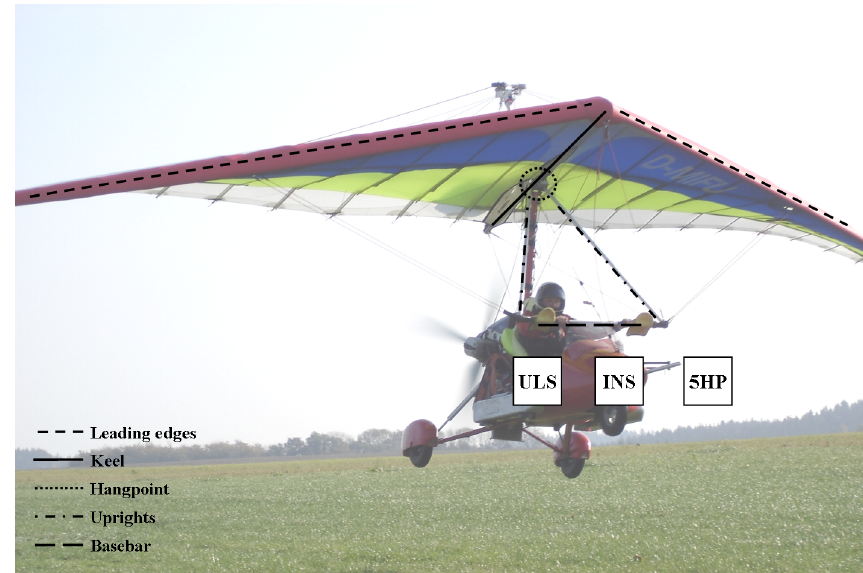
Fig. 1. Weight-shift microlight research aircraft D-MIFU, aircraft structural features are highlighted by dash-dotted lines. Sensor locations of the five hole probe (5HP), inertial navigation system (INS, inside aircraft nose) and universal laser sensor (ULS, below pilot seat) are indicated. For details on the respective installations see Sect. 2.2 and Table 2. Figure 3 details the layout of the five hole probe.